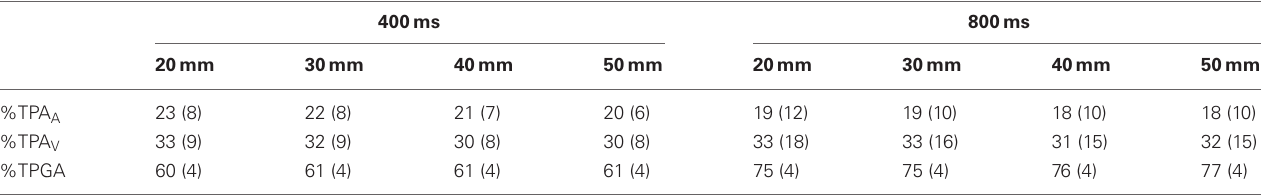
Table 1 | Percent time to peak aperture acceleration, peak aperture velocity, and peak grip aperture in the 400 and 800ms conditions and as a function of object size (20, 30, 40, and